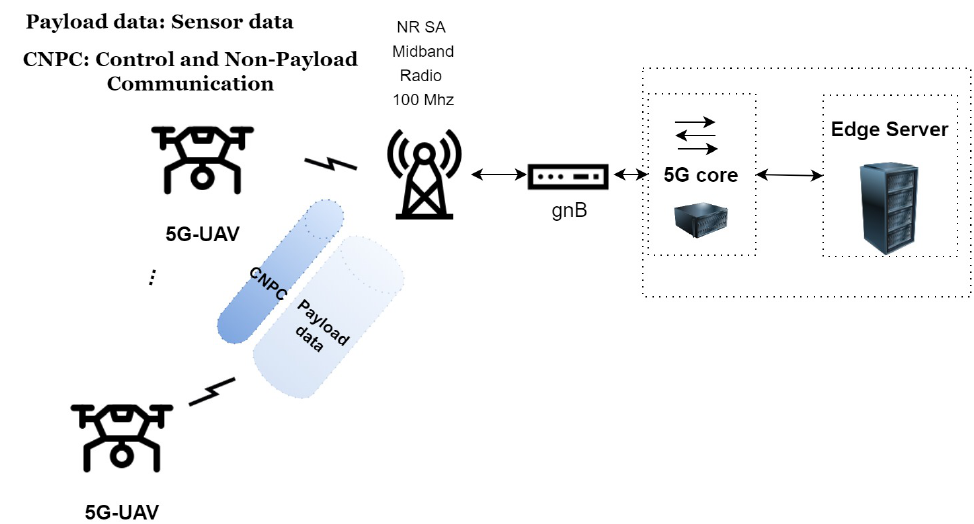
Figure 1. A 5G-UAV, control and non-payload communication, and payload communication. UAV Payload Communication